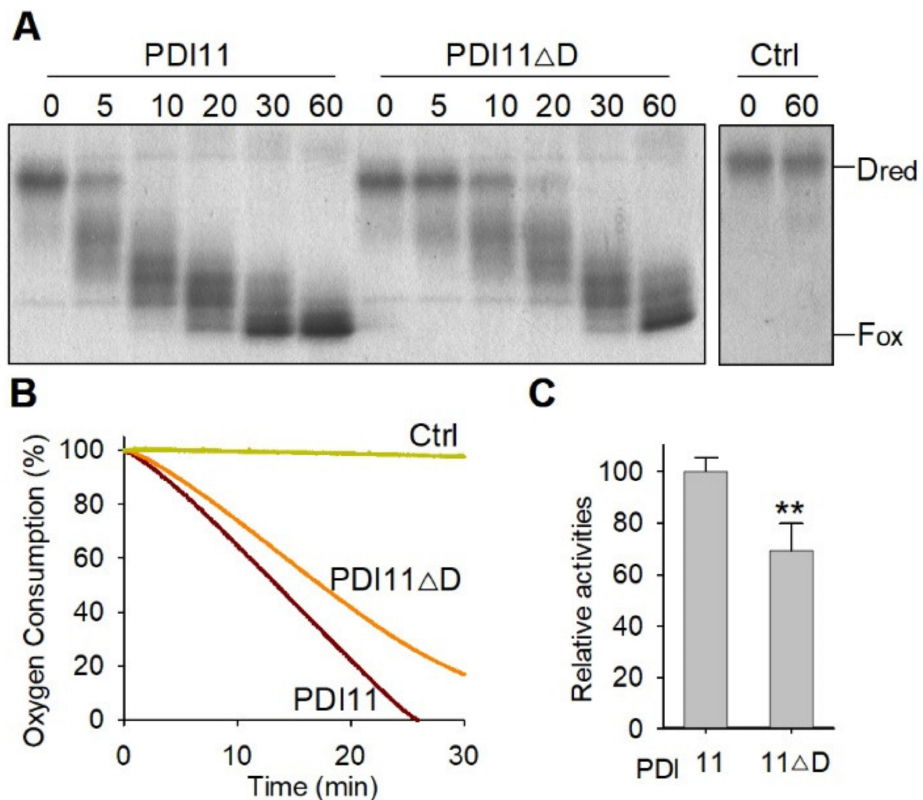
Figure 6. The D domain is required for the enzyme activities of AtPDI11. ( A ) Analysis of AtPDI11 and AtPDI11 ∆ D activities based on gel-based RNase A refolding assay. In total, 8 µ M denatured and reduced RNase A was incubated in buffer B containing 3 µ M AtPDI11 or AtPDI11 ∆ D , 3 µ M AtERO1, and 100 µ M FAD at 25 ◦ C. The same volume of sample from the reaction mixture was quenched with AMS at various time points and separated by 15% non-reducing SDS-PAGE. Dred: denatured and reduced RNase A; Fox: fully oxidation RNase A. Control: Reaction without AtPDI11 or AtPDI11 ∆ D . ( B ) Comparison of enzyme activity between AtPDI11 and AtPDI11 ∆ D by oxygen consumption assays. Oxygen consumption was monitored in buffer B containing 2 µ M AtERO1, 20 µ M AtPDI11 or AtPDI11 ∆ D , 20 µ M FAD and 10 mM GSH, and GSH was supplied as reducing equivalents. Control: Reaction without AtPDI11 or AtPDI11 ∆ D . ( C ) Statistical analyses of enzyme activity between AtPDI11 and AtPDI11 ∆ D . Relative enzyme activities were estimated by measuring the slope of the linear phase of the oxygen consumption curve in ( B ) after subtracting the control. Values are the means of three biological repeats ± SE ( n = 3). Statistical significance was determined by Student’s t -tests. ** p <